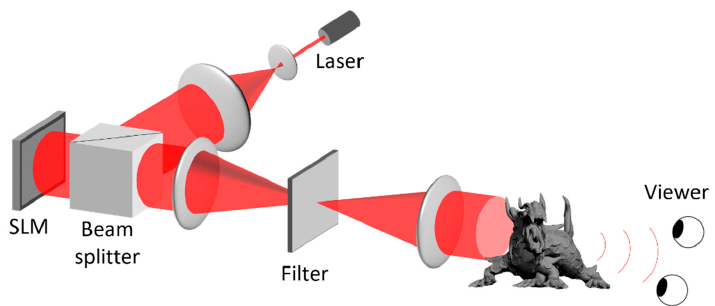
Figure 4. Optical diagram of the holographic reconstruction experiment.